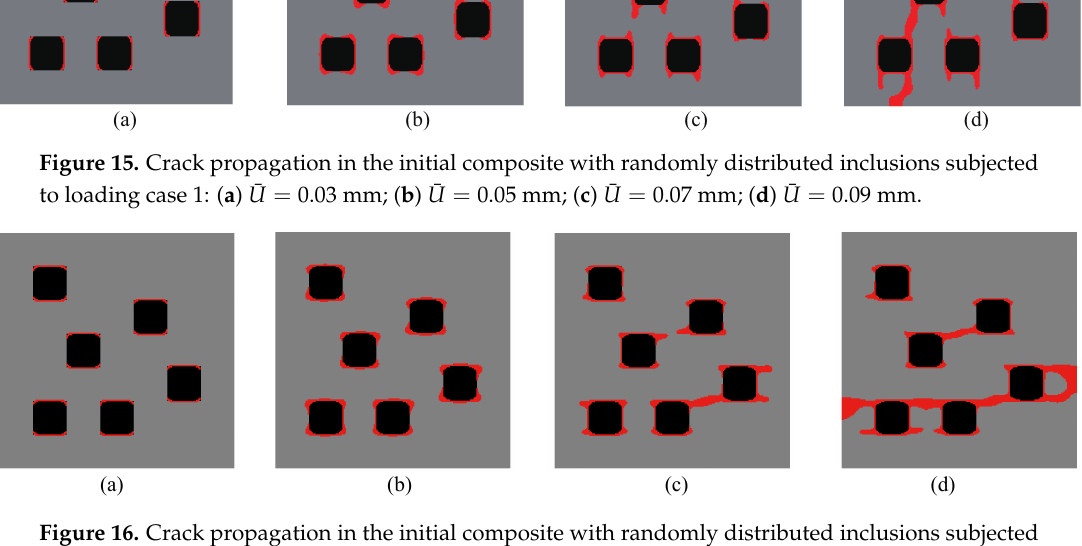
Figure 16. Crack propagation in the initial composite with randomly distributed inclusions subjected to loading case 2: ( a ) ¯ U = 0.03 mm; ( b ) ¯ U = 0.05 mm; ( c ) ¯ U = 0.07 mm; ( d ) ¯ U = 0.09 mm.